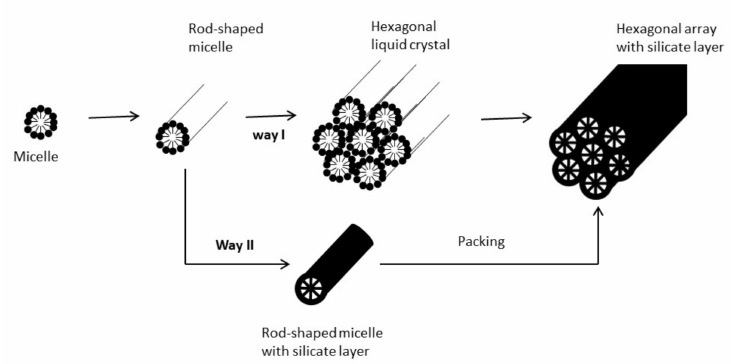
Figure 3. Schematic model of the liquid crystal templating mechanism via two possible